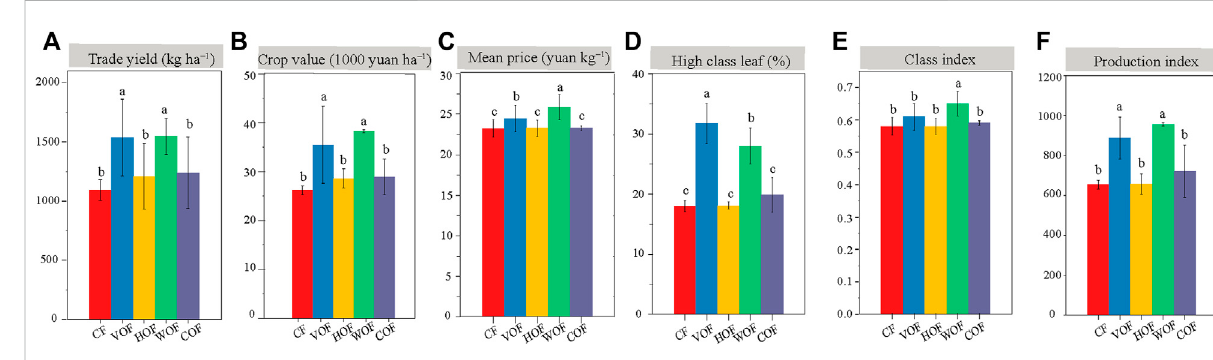
FIGURE 1 Yield (A) and economic value (B – F) of tobacco leaf. CF, VOF, HOF, WOF, and COF represent the treatments of tobacco-special chemical fertilizer, vermicompost-based, humic acid-based, wood biochar-based, and compound functional organic fertilizers, respectively. Different letters within each index show a signi fi cant difference based on the Duncan ’ s method ( p <